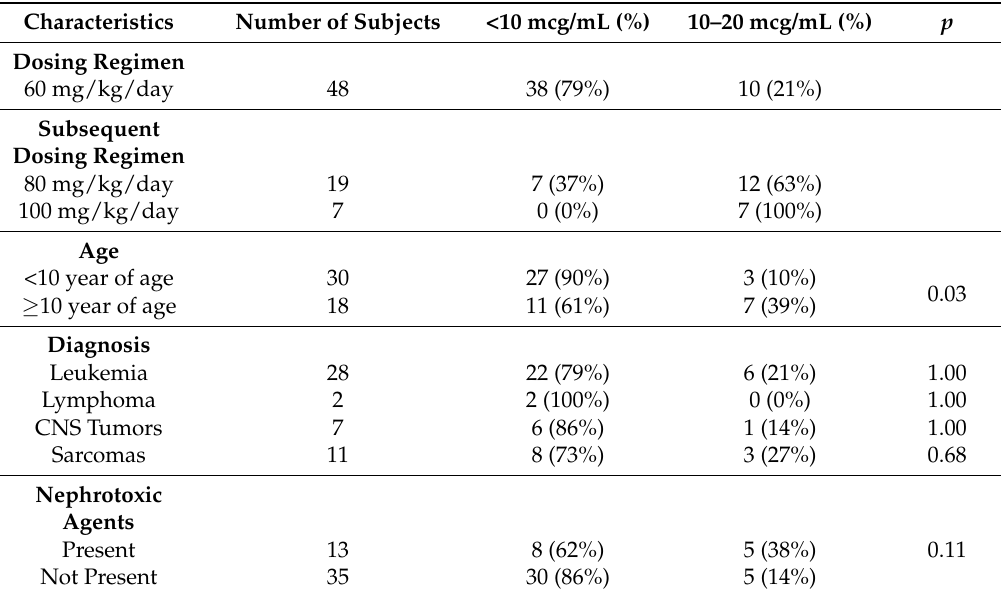
Table 1. Patient and vancomycin pharmacokinetic